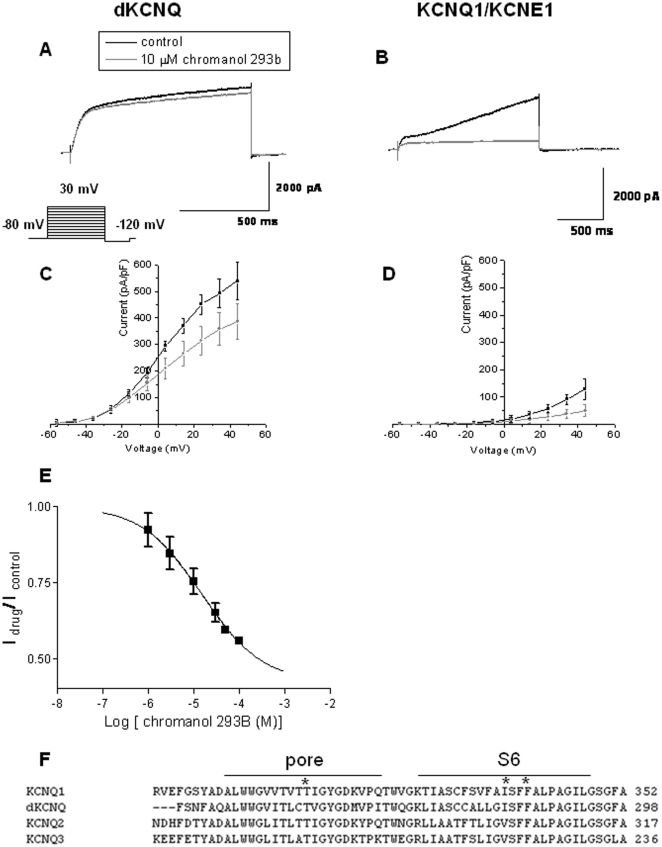
Chromanol 293B show conserved inhibition of Drosophila and mammalian KCNQ1/KCNE1 channels.Representative traces showing dKCNQ (A) current (black) was sensitive to block by 10 µM chromanol 293B (grey), this is also reflected in the downward shift of the I-V curve (C). Traces (B) and I-V curves (D) showing KCNQ1/KCNE1 was sensitive to block by 10 µM chromanol 293B. (E) Dose response curve for chromanol 293B effect on dKCNQ current. The block was reversible. F) Alignment of KCNQ1, dKCNQ, KCNQ2 and KCNQ3 channels protein sequence in the region of the pore loop and S6 transmembrane segment. The important residues for the chromanol 293B binding site are marked by asterisks [4]. dKCNQ n = 8 and KCNQ1/KCNE1 n = 4.